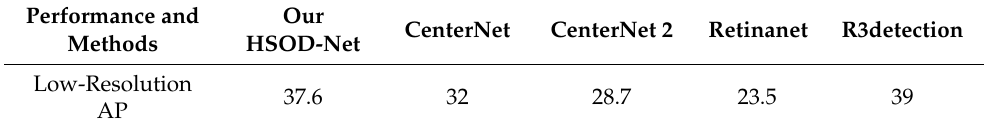
Table 3. Model performance on low-resolution DOTA